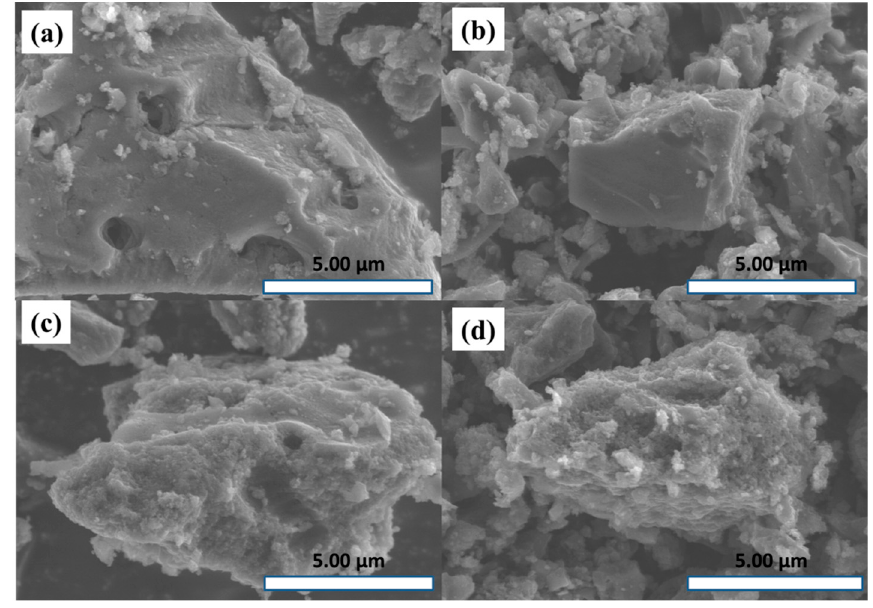
Figure 2. SEM images of ( a ) AC-o, ( b ) AC-s, ( c ) AC-a, and ( d ) AC-m.